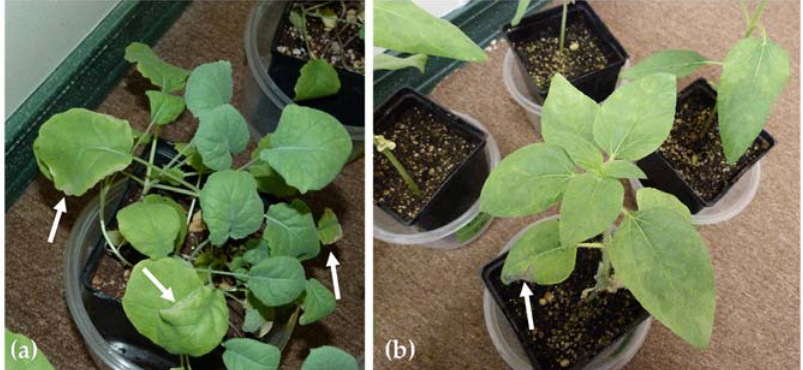
Figure 4. Example ( a ) B. napus and ( b ) H. annuus plants at week 3. Arrows in ( a ) are pointing out areas of chlorosis around leaf edges. The arrow in ( b ) is pointing out a necrotic spot.